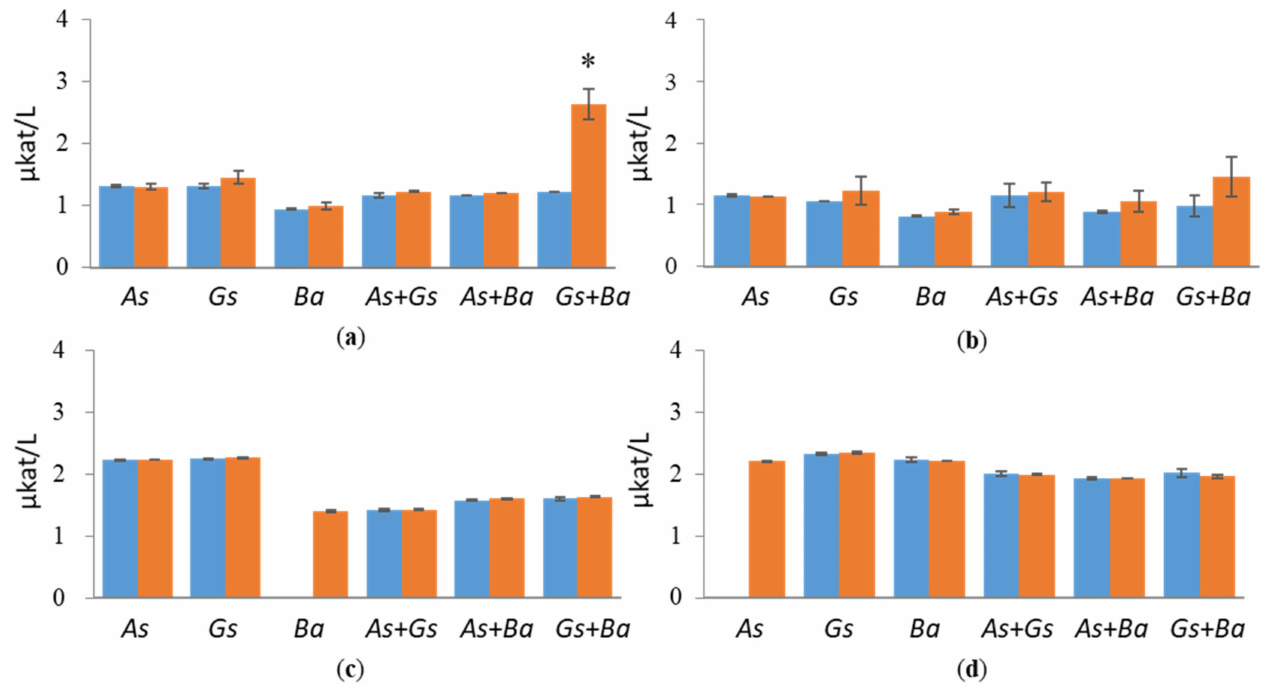
Figure 1. Endoglucanase (EG) activities at early (day 10, marked in blue) and late time points (day 24, marked in red) in single and co-cultivation on ( a ) birch, ( b ) spruce, ( c ) pine wood and ( d ) Avicel. As = A. sinuosa , Gs = G. sepiarium , Ba = B. adusta , As + Gs = A. sinuosa and G. sepiarium , As + Ba = A. sinuosa and B. adusta , Gs+Ba = G. sepiarium and B. adusta . Error bars refer to standard deviation (SD) ( n = 3). * indicates statistical difference among single and co-cultivations ( p <